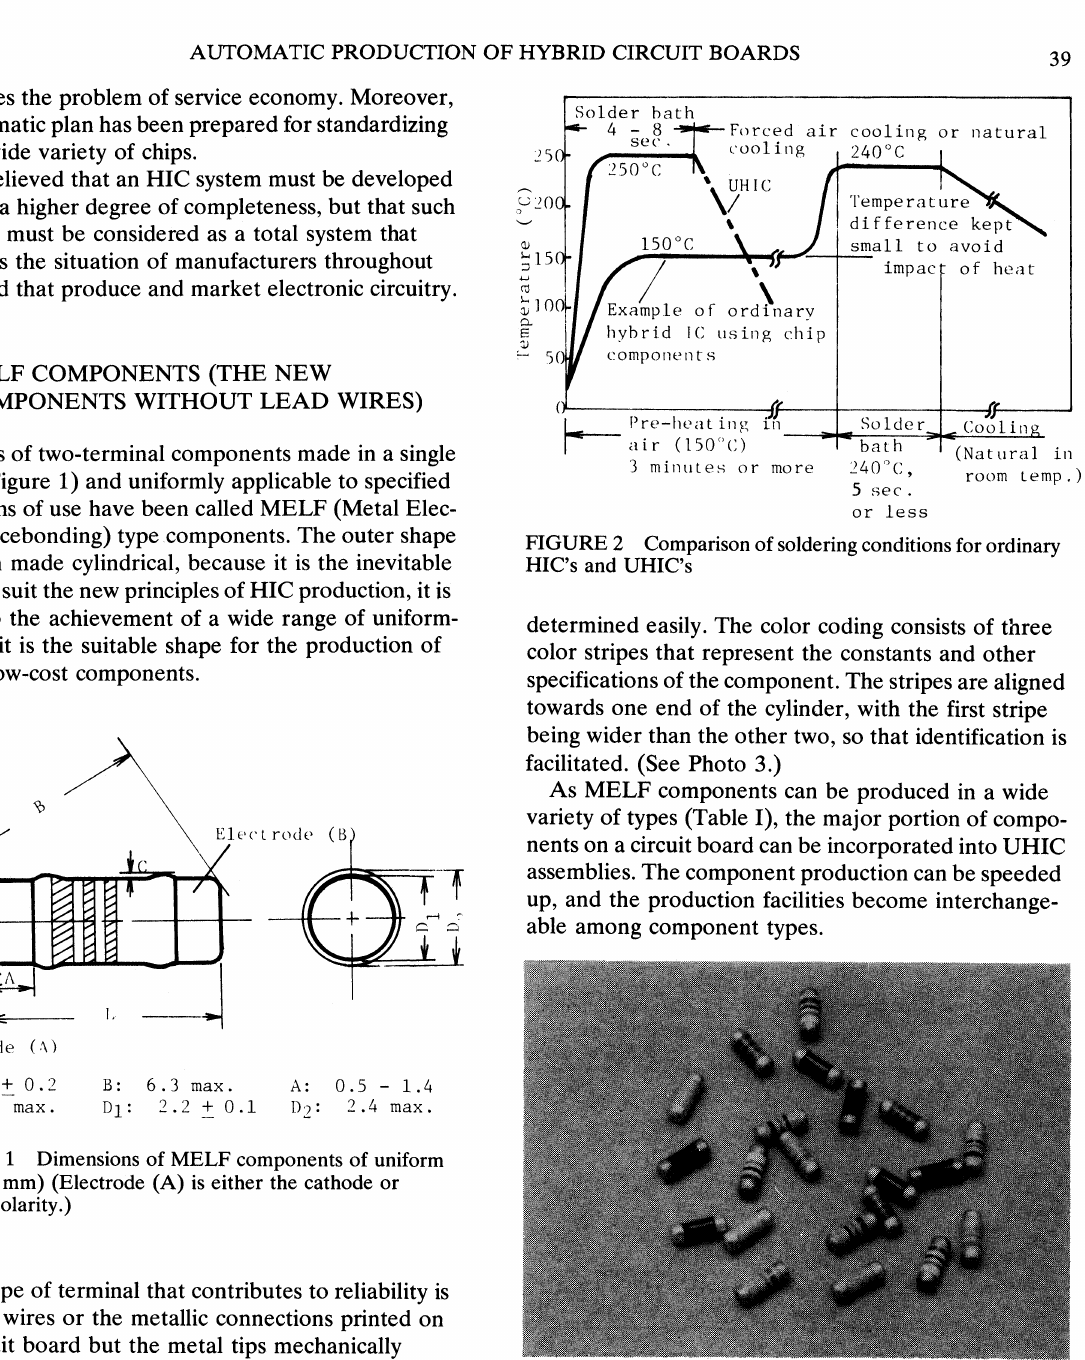
FIGURE 1 Dimensions of MELF components of uniform shape (in mm) (Electrode (A) is either the cathode or positive polarity.)